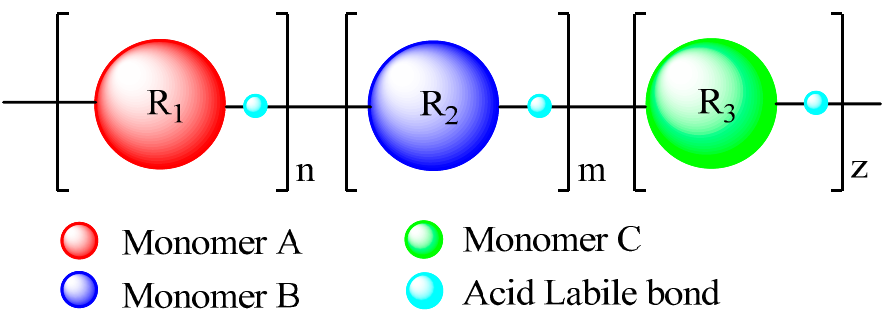
Figure 6. Chemical structure of the backbone breakable random copolymer. The copolymer is consisted of three different monomers connected by an acid labile bond. Each monomer introduces or tunes a specific property of the polymer. Adapted from [70], with permission from SPIE and the author Theodore Manouras, 2020.